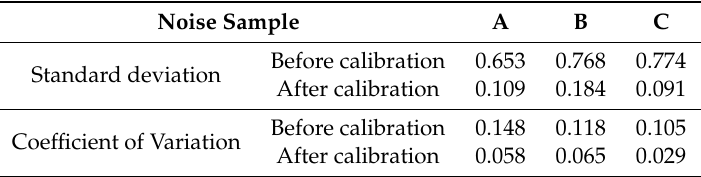
Table 4. The standard deviation and coefficient of variation of MA for samples A–C obtained from sample sets 1–3 before and after